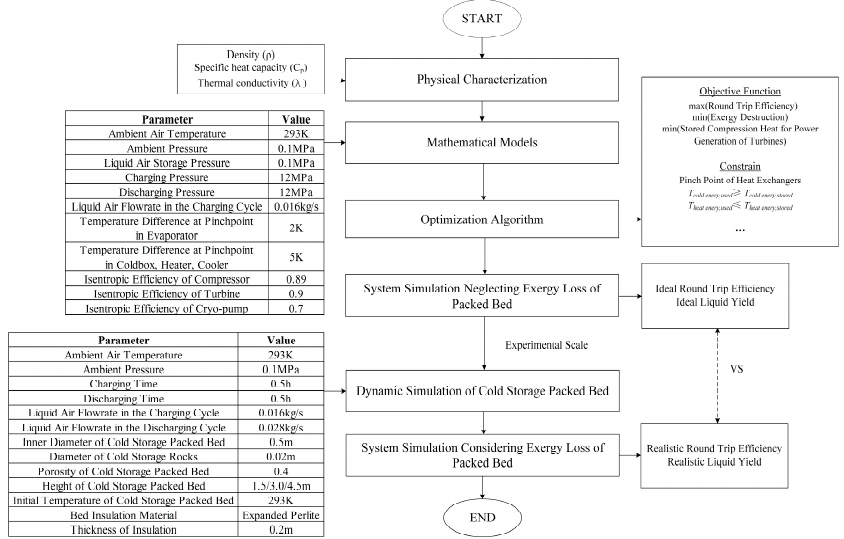
Figure 4. Schematic of solution methodology of this work.